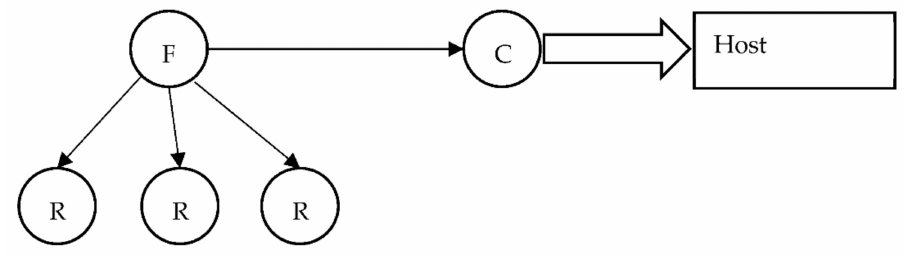
Figure 16. Schematic diagram of simulation equipment